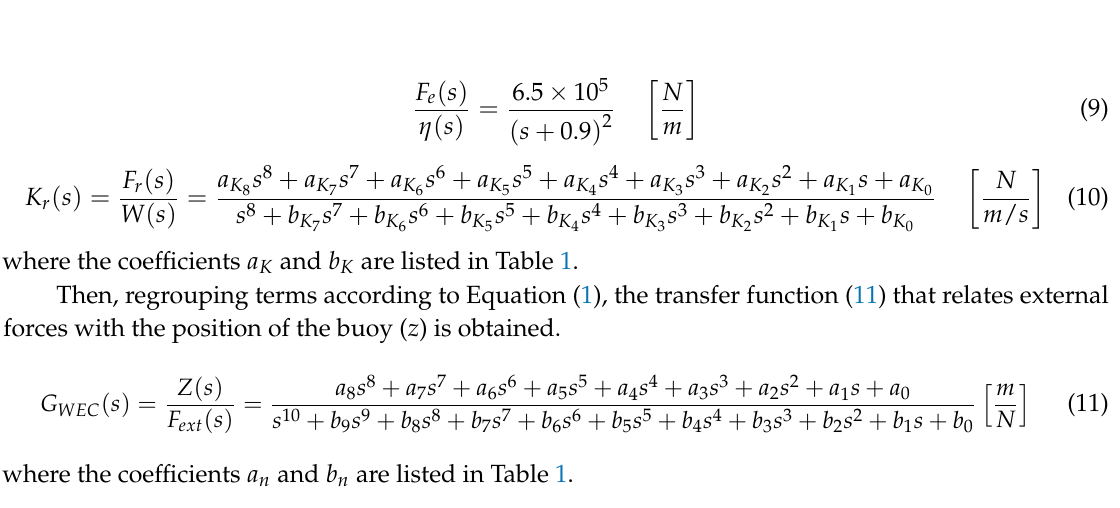
Table 1. Model coefficients identified for the WEC